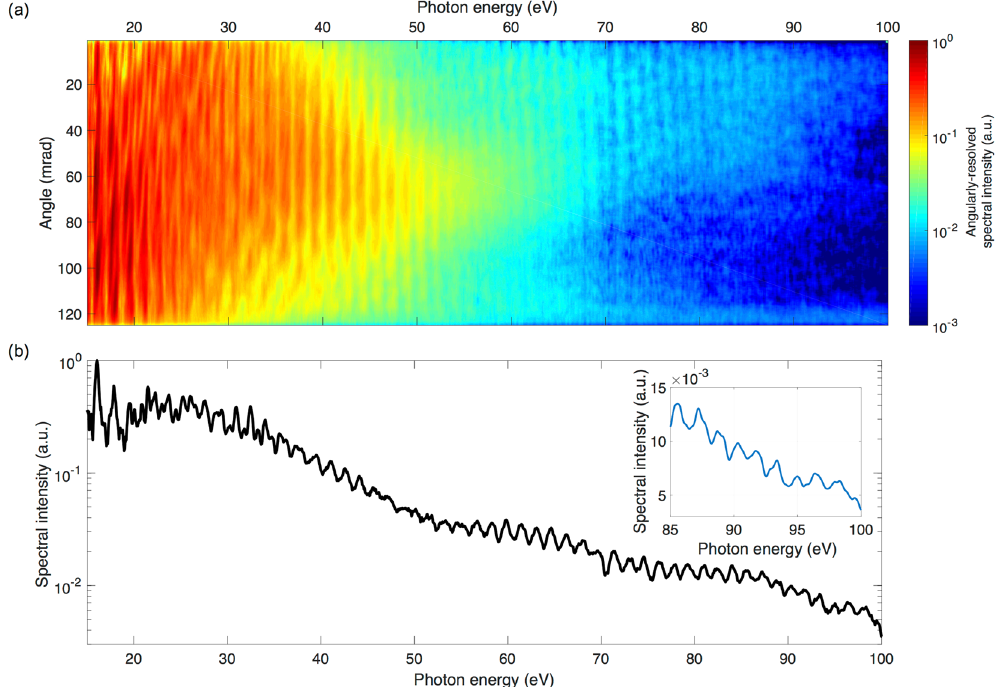
Figure 3. Relativistic high-order harmonic spectrum. The sub-5-fs pulse is tightly focused [see Fig. 2 (e)] onto a glass target and the reflected beam is directed into an XUV spectrometer. ( a ) Single-shot angularly- resolved high-harmonic spectral intensity of the generated XUV radiation in a logarithmic colour scale. ( b ) Corresponding angular integration between 0–20 mrad of the spectral intensity showing photon energy cutoff up to 100 eV. Inset: high-order harmonics at the highest photon energies in a linear scale.